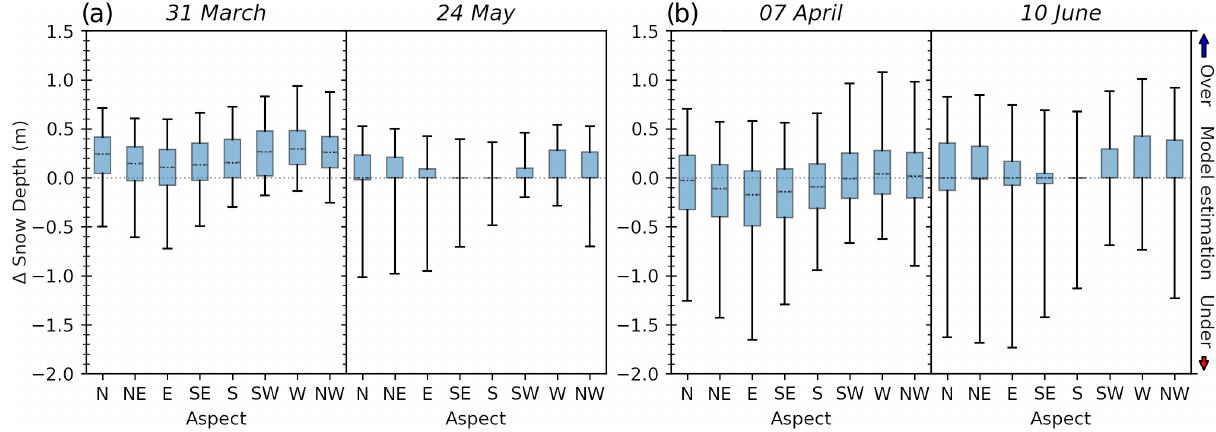
Figure 7. Snow depth differences for the water years 2018 (a) and 2019 (b) between ASO and HRRR-iSnobal binned by aspect.